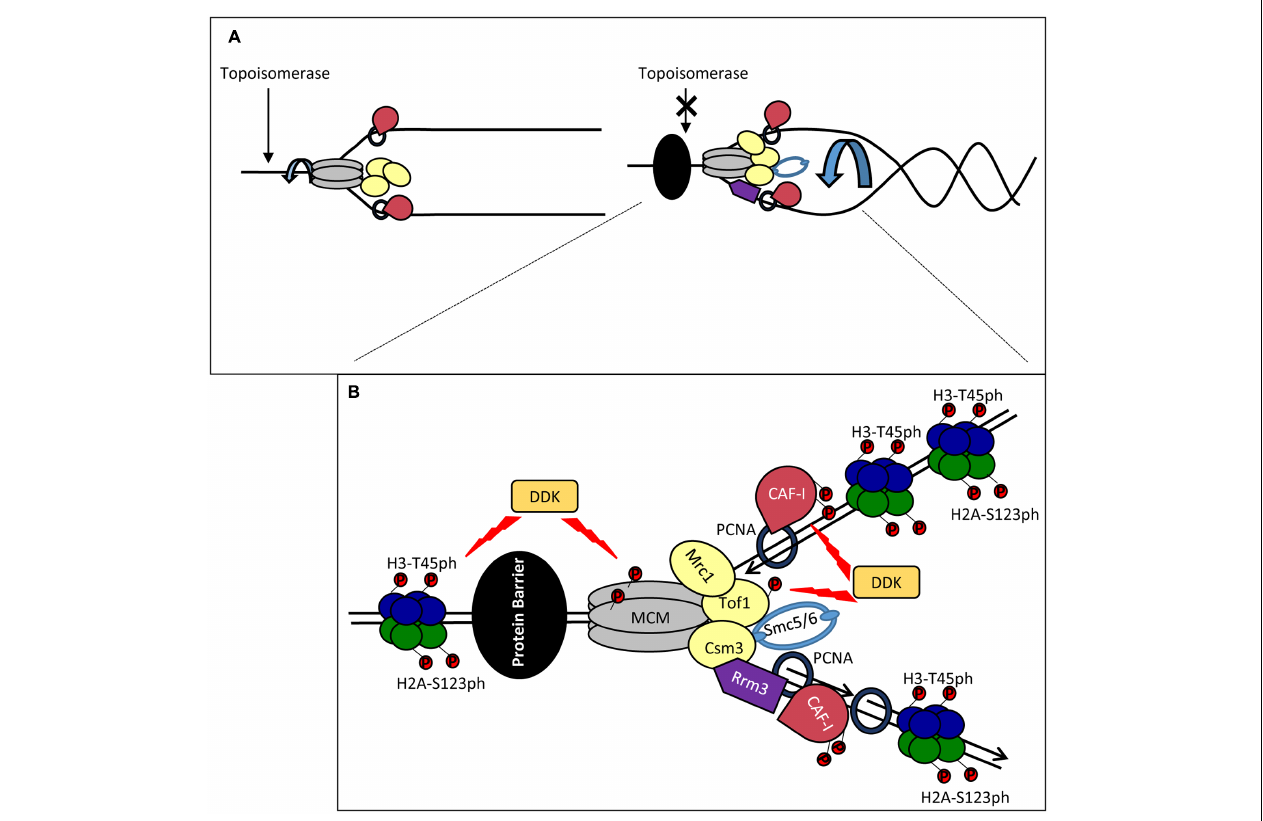
FIGURE 2 | Stalling of a replication forks: distortion, stabilization and restarting. (A) Fork catenation and distortion at paused replication forks. During elongation, supercoiling and fork rotation are relieved by topoisomerases and the FPC (Left). The action of topoisomerases are inhibited by impediments (a non-histone DNA-binding protein is shown by a black oval), resulting in fork rotation and catenation (Right). (B) Stabilization and phosphorylation of fork components. The paused replisome is stabilized by the FPC (Mrc1p, Tof1p and Csm3p) which associates via the CMG helicase. DDK phosphorylates (red circles) MCM and Tof1p and contributes to fork stability. Other potential DDK targets include CAF-I and H3T45. H2A-S123 phosphorylation also occurs at a paused replication fork but the kinase is unknown. Rrm3p (purple) associates with PCNA on the lagging strand and removes the tightly bound protein via 5 (cid:48) -3 (cid:48) helicase activity. Smc5/6 (light blue) cooperates with Rrm3p and FPC and counteracts prolonged pausing caused by Tof1p-Csm3p. For simplicity, new histones, Asf1, FACT and Rtt106 are not shown. It is not established if the histones are phosphorylated ahead of or behind the